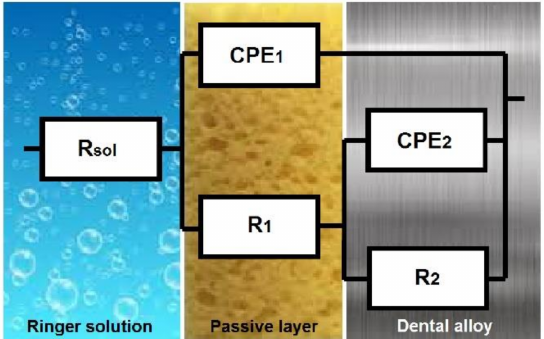
Figure 8. EC used to generate the simulated data for specimens Ni1, Ni2, Ni3, Co1, and Co2.